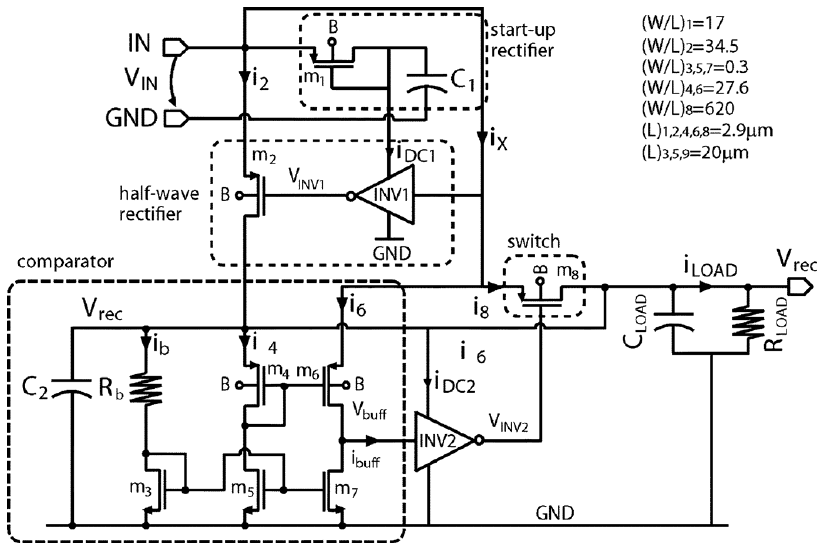
Figure 18. Circuit diagram of the single-stage active rectifier realized in [48]. Reproduced with permission from F. Mazzilli, IEEE Transactions on Biomedical Circuits and Systems; published by IEEE,